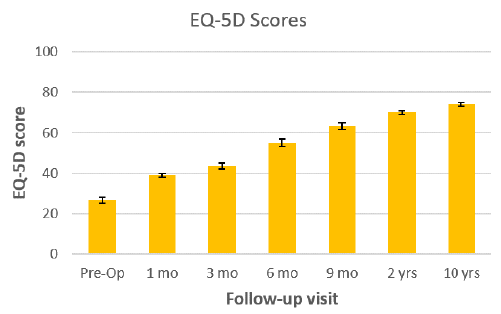
Figure 2. Pre- and post-treatment SF-12 physical and mental component scores ( n = 3, 10 years follow-up) are shown at 1, 3, 6, 9, months, 2 years and 10 years after surgical treatment with percutaneous posterior fixation.